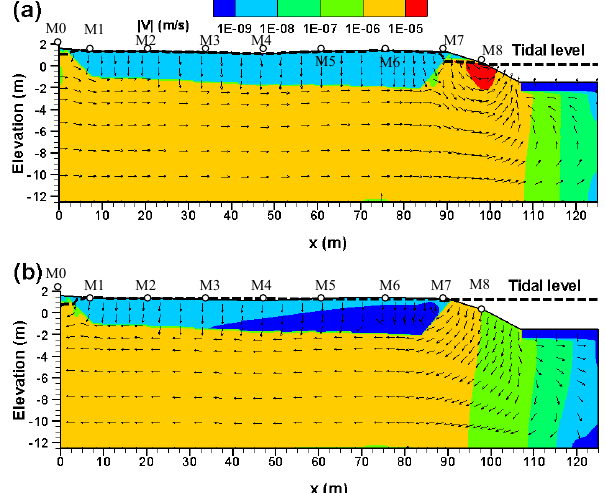
Fig. 9. Darcy velocities (banded colorful contours) in the mangrove transect (a) at low tide (Time=35.5 h) and (b) at high tide (Time=41.0 h). Vectors with uniform length were used to indicate the velocity direction only. The long dash line denotes water